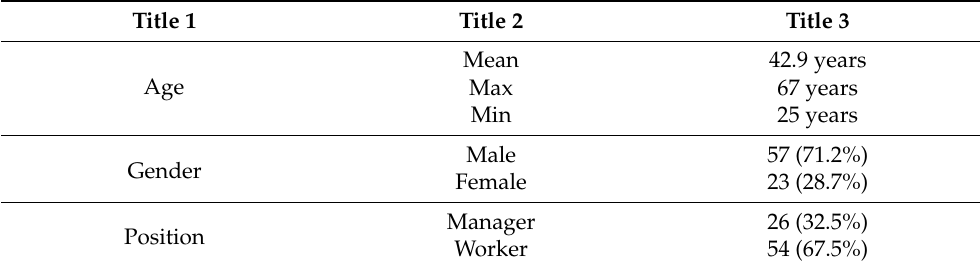
Table 4. Background information concerning the interviewed